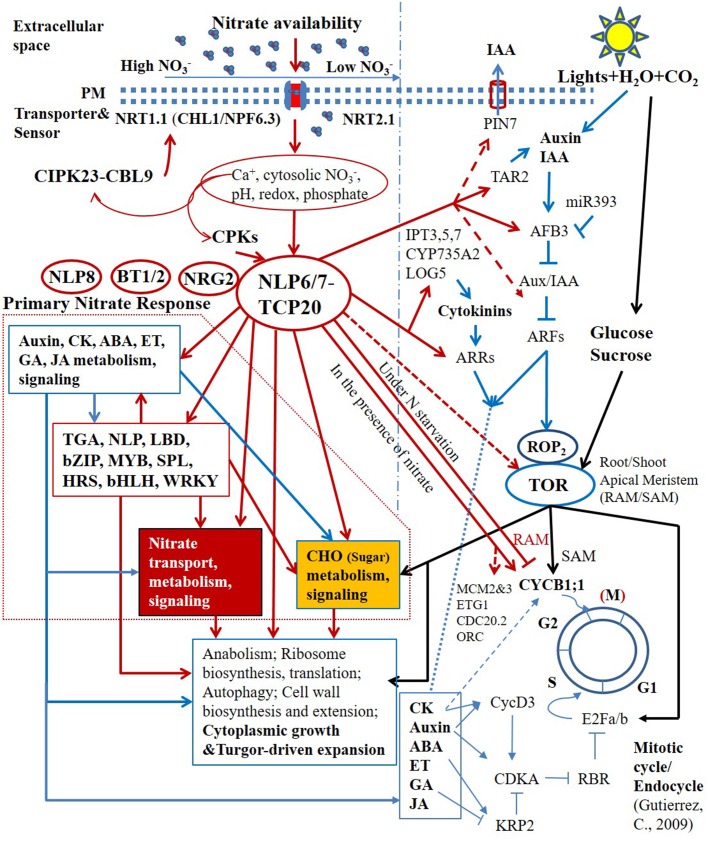
Schematic representation of the central regulatory role of TCP20-NLP6/7 complexes in nitrate transcriptional hierarchy and nutrient-growth networks. Arrows and blunted lines represent positive and inhibitory regulations, respectively. Solid lines indicate defined pathways, whereas dashed lines indicate presumed or initially confirmed pathways.